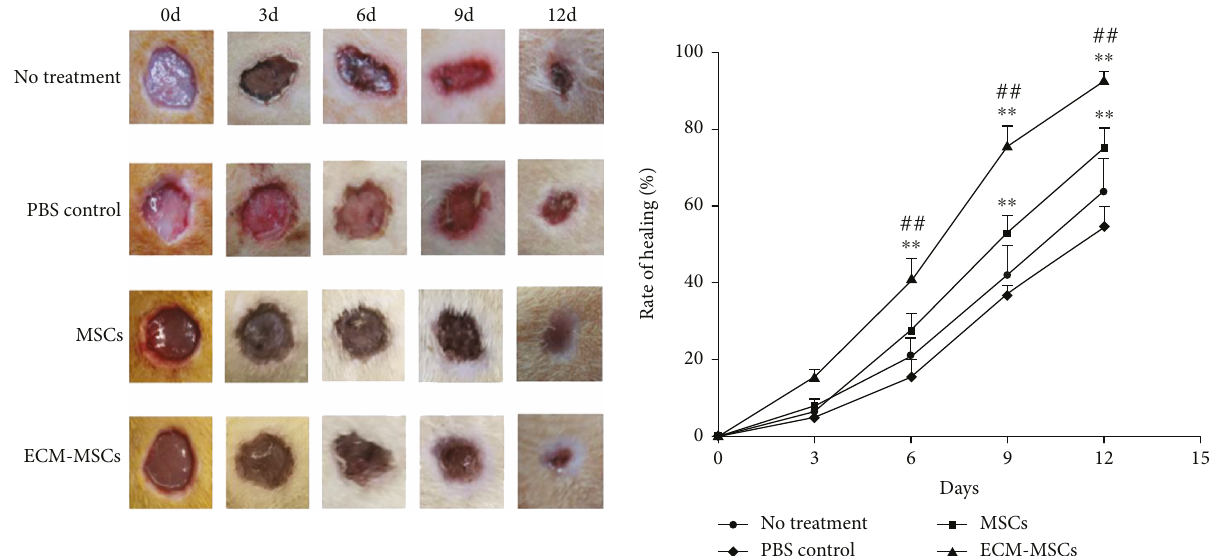
Figure 2: Wound healing at 0, 3, 6, 9, and 12 days for groups of no treatment, control, MSCs, and ECM-MSCs. The rate of healing was the percentage of the reduced wound area vs. the original wound area (%). n = 6 , ∗∗ P < 0 01 vs. the control group; ## P < 0 01 vs. the MSC